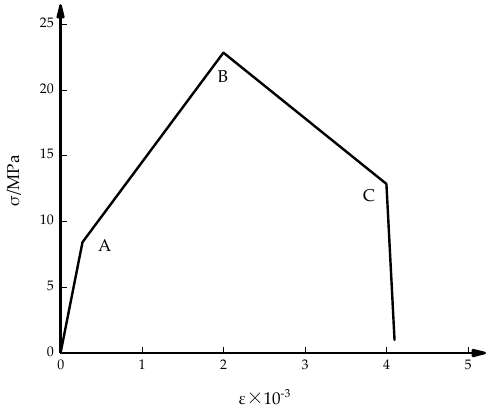
Figure 7. Constitutive model of the frame column.